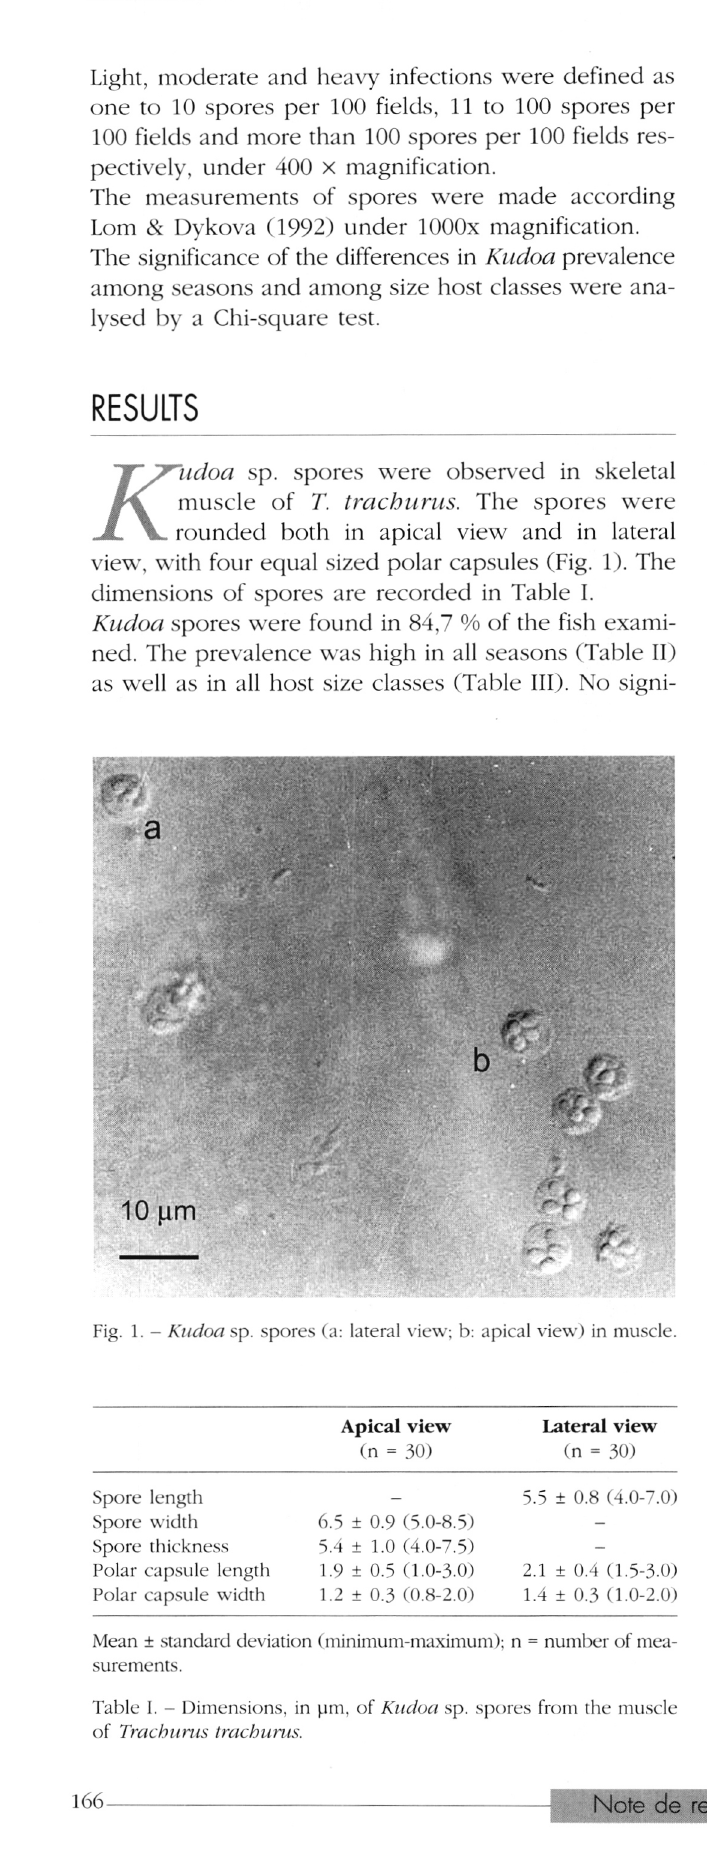
Table I. - Dimensions, in pm, of Kudoa sp. spores from the muscle of Trachurus